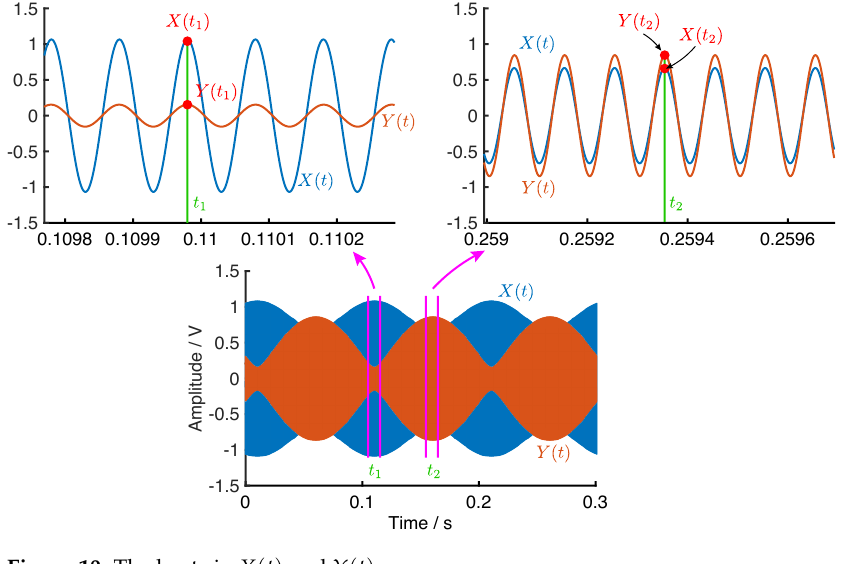
Figure 10. The beats in X ( t ) and Y ( t )